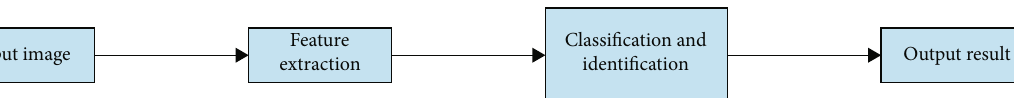
Figure 3: Lip print recognition fl ow based on LPRNet.